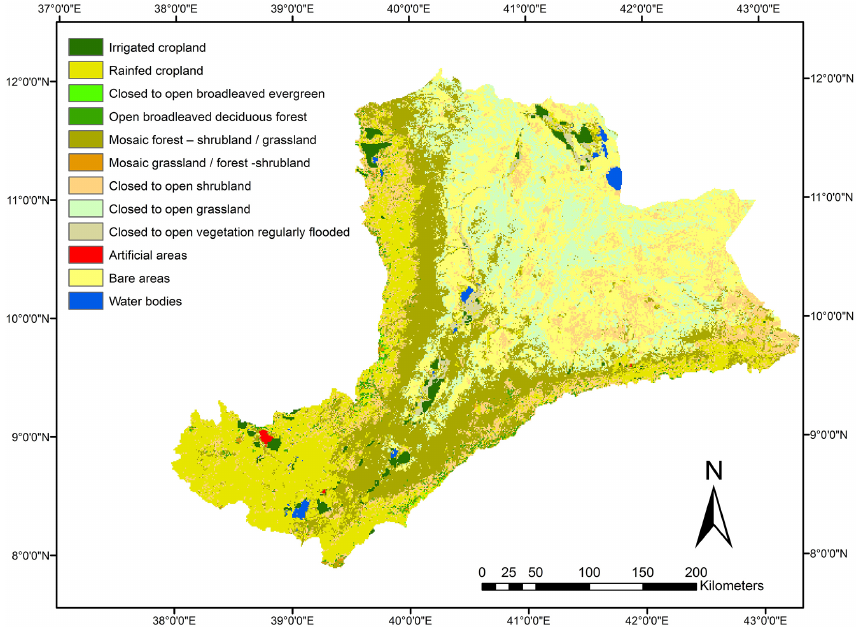
Figure 4. Updated spatial distribution of land use in the Awash Basin (after Dost et al., 2013).